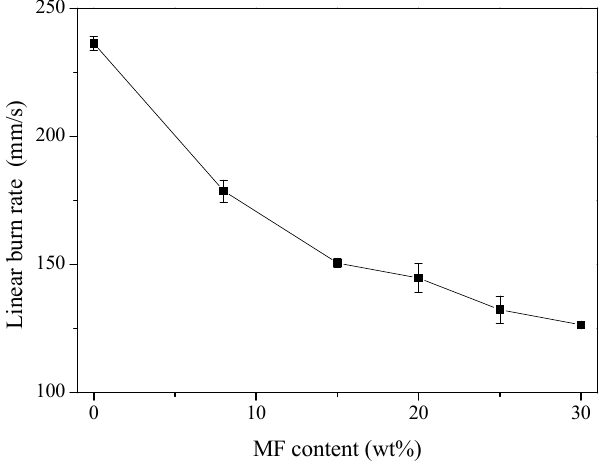
Figure 10. Linear burning rate of PU/MF foams as a function of MF content, reproduced from [97] with permission, copyright Springer Nature, 2016.